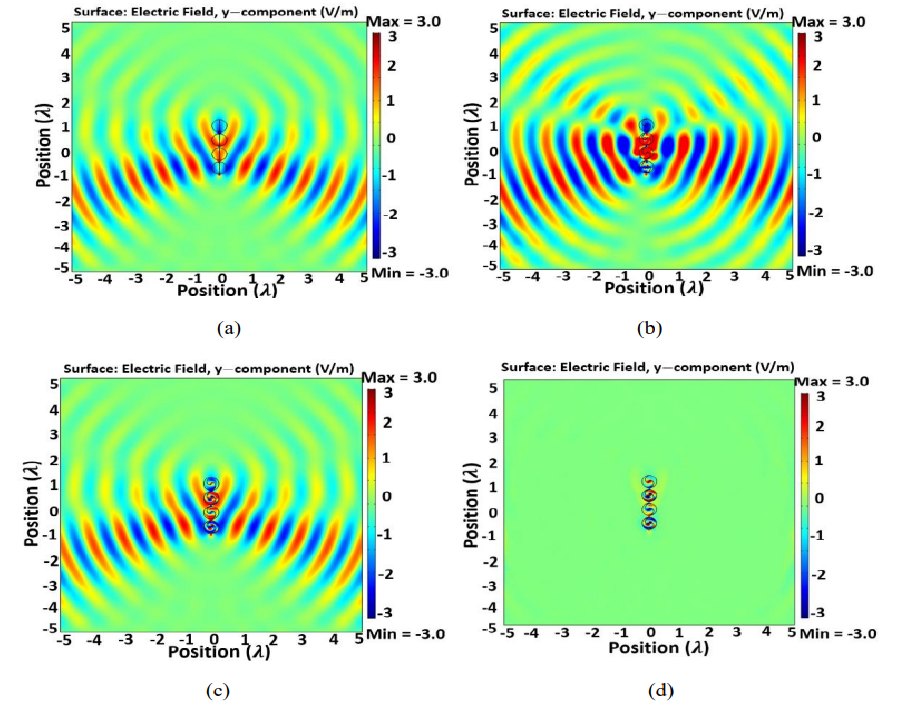
Figure 5. Total electric field distributions for three different array configurations for a scan angle of θ s = 22.50 for [53] ( a ) reference/original dipole antenna linear array, ( b ) “pinwheel” antenna array without any material compensation, ( c ) material − embedded “pinwheel” shaped antenna linear array, and ( d ) difference between the electric fields in ( a , c